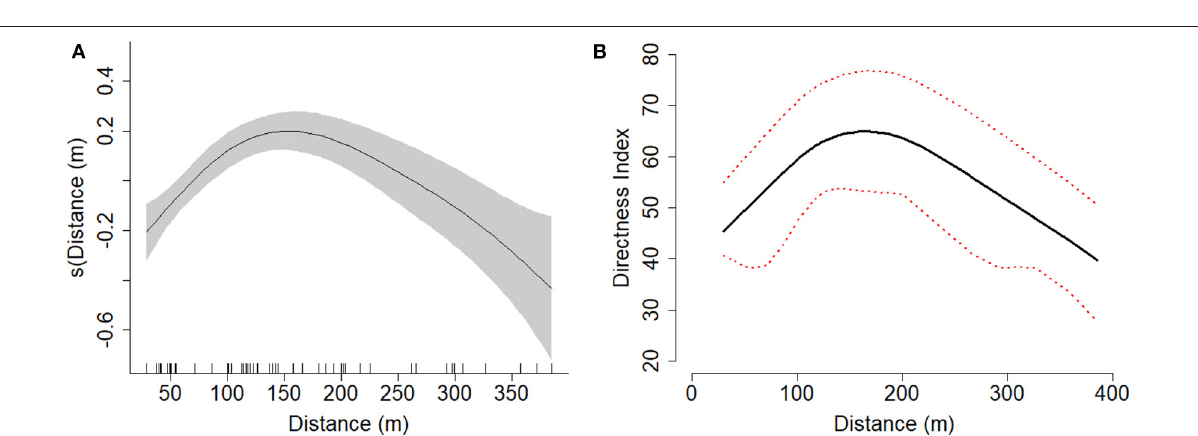
FIGURE 9 | Results from the best fit generalized additive model (GAM) for humpback whale path directness showing (A) model parameter estimates of vessel distance to focal group and (B) model predicted path directness based on vessel distance. The shaded and dashed lines represent the 95% confidence intervals of the parameter estimates and fitted values, respectively. The vertical ticks on image (A) indicate the locations of observations (i.e., a